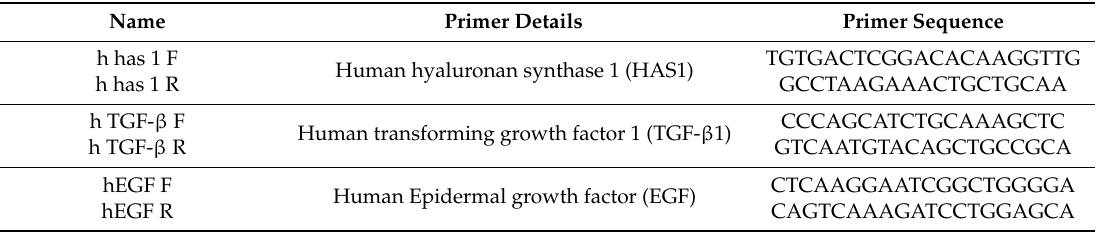
Table 1. List of forward and reverse primers used in quantitative real-time PCR (qRT-PCR)